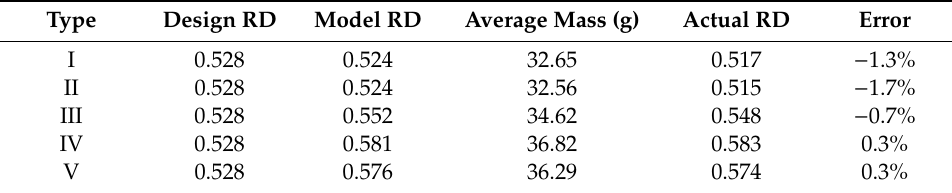
Table 1. Analysis of RD for fabricated